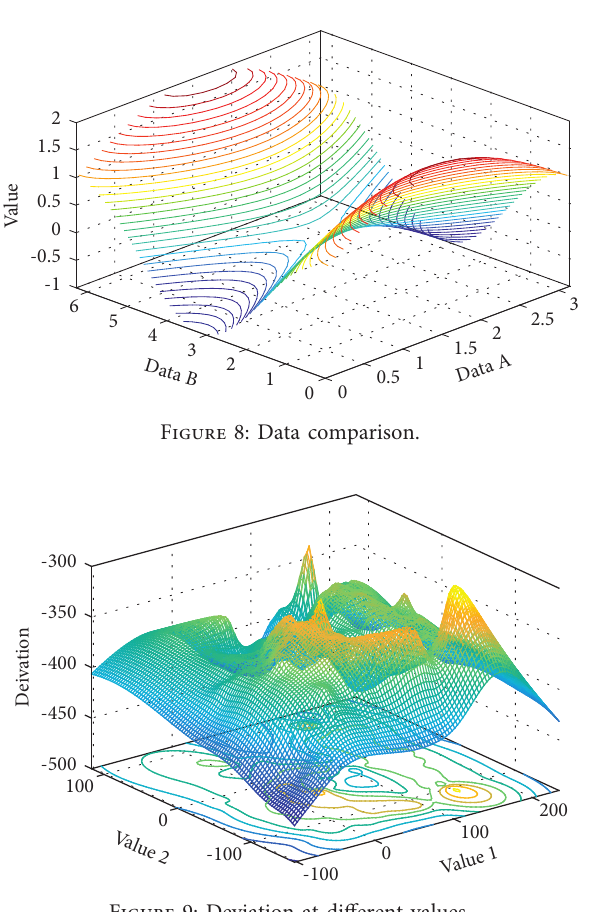
Figure 9: Deviation at different